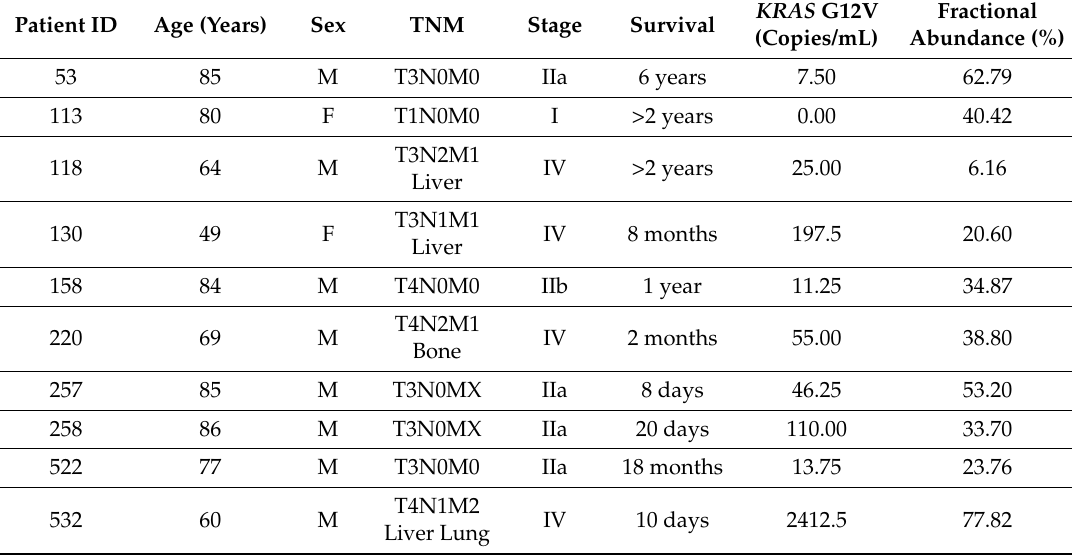
Table 1. Clinical features of patients included in the